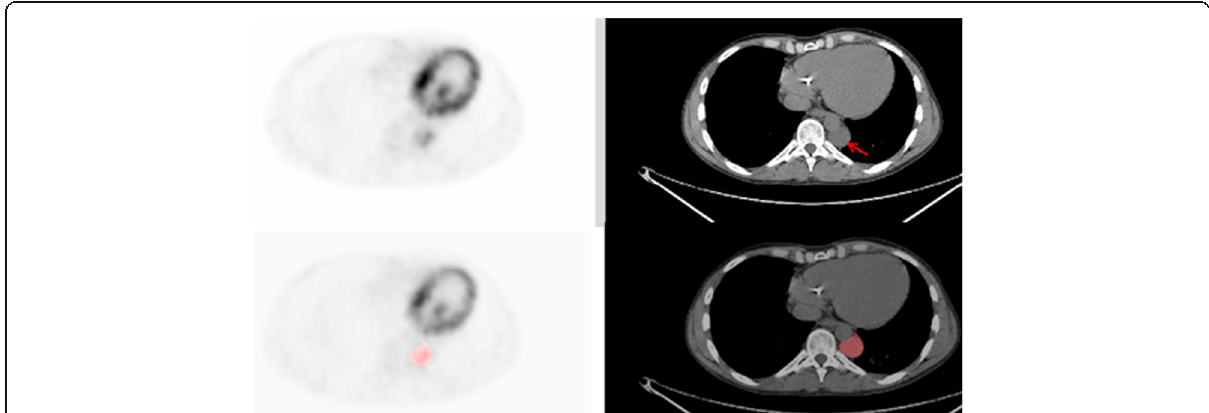
Fig. 1 Axial 18 F-FDG PET and CT scans. The tumour is indicated by the arrow ( above ). A region of interest is shown on the same PET and CT slice of the tumour ( below